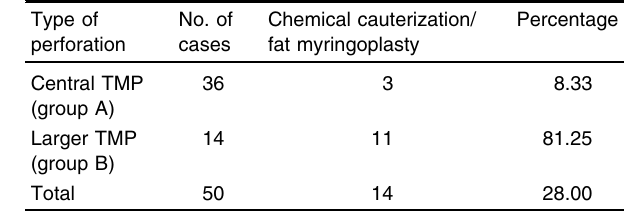
Table 5 Conservative management Table 6 Chemical cauterization/fat